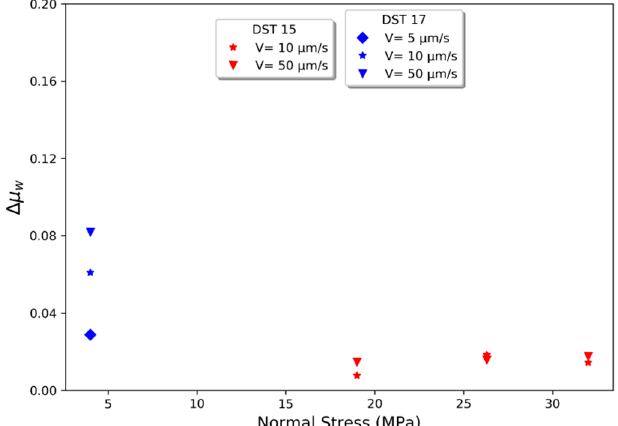
Figure 11. Relationship between frictional weakening and applied normal stress for the Draupne specimens. For low normal stress, the higher the shear velocity, the higher is the magnitude of frictional weakening. For higher normal stress, frictional weakening does not show any clear dependency on the shear velocity.